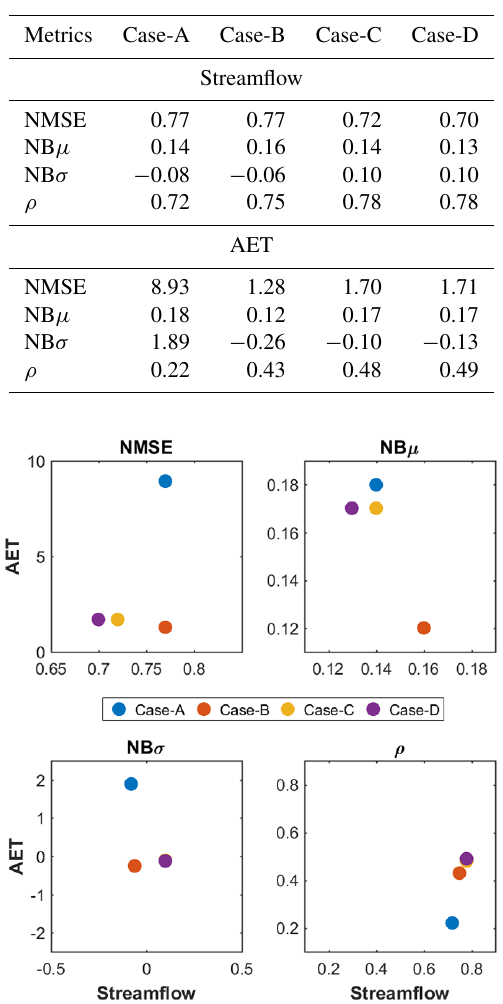
Table 7. Streamflow and AET error statistics in total simulation for all four cases in Stage-II Step-1 analysis.